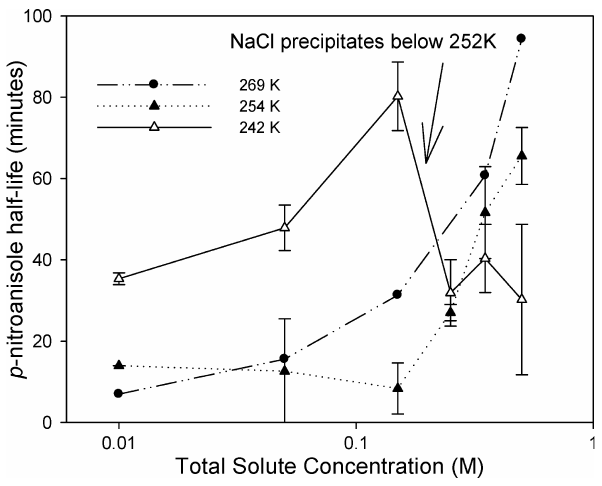
Fig. 15. Observed reactivity of p-nitroanisole in frozen aqueous so- lutions as a function of total solute concentration adjusted by the addition of NaCl at 269 K (filled circles), 254 K (filled triangles), and 242 K (open triangles). The lower the NaCl concentration, the smaller the volume of brine. The higher concentration of the bi-molecular reaction partners, p-nitroanisole and pyridine in the smaller liquid volume might explain the apparent higher reactiv- ity with lower total solute concentration. Reprinted with permission from Grannas et al. (2007a) Copyright (2007) American Chemical